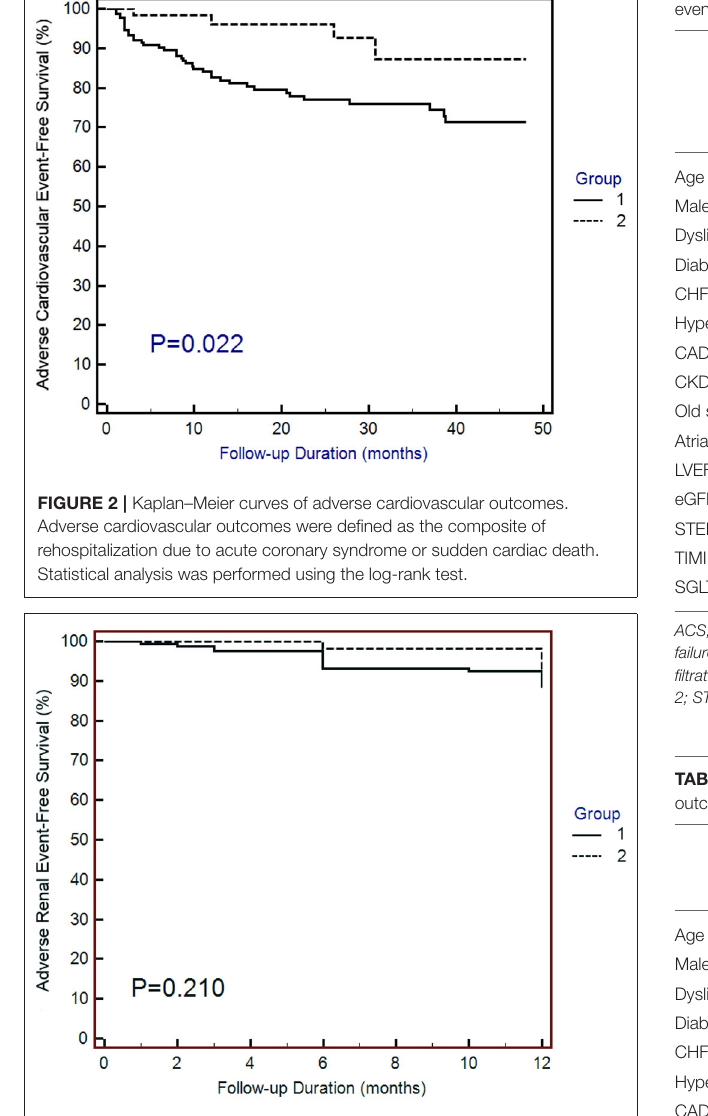
FIGURE 3 | Kaplan–Meier curves of adverse renal outcomes. Adverse renal outcomes were defined as chronic dialysis, renal transplant, sustained reduction of ≥ 40% eGFR, or sustained eGFR < 15 mL/min/1.73 m 2 for patients with eGFR ≥ 30 mL/min/1.73 m 2 at baseline. The adverse renal outcomes were similar between the two groups. Statistical analysis was performed using the log-rank test.